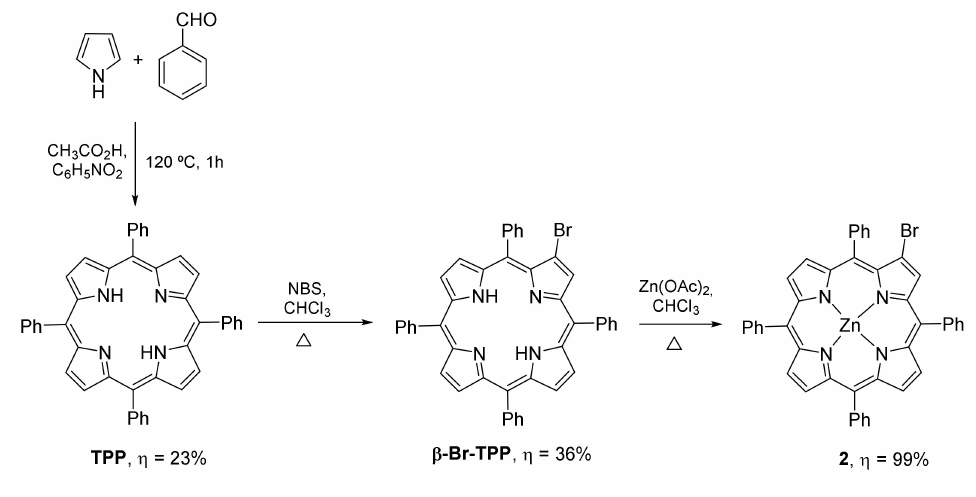
Scheme 2. Synthesis of porphyrin 2 used as template in the reactions with the